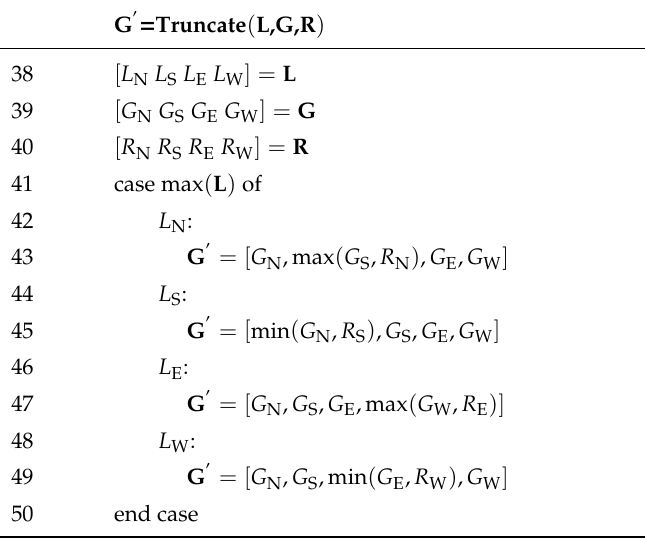
Table 5. Valid velocity space